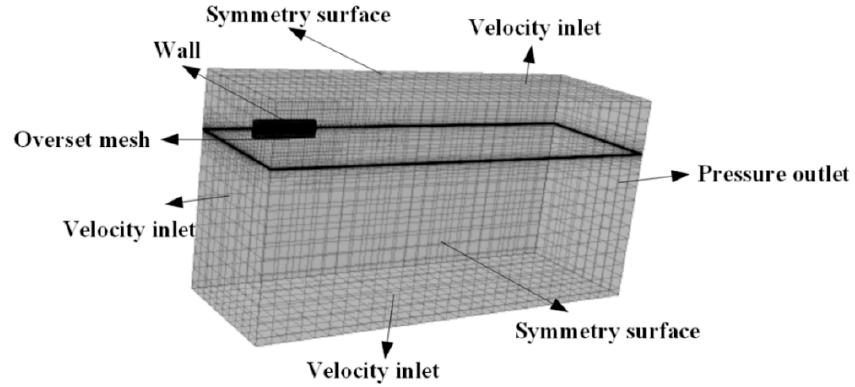
Figure 4. The boundary conditions and the mesh on the whole CFD numerical tank.